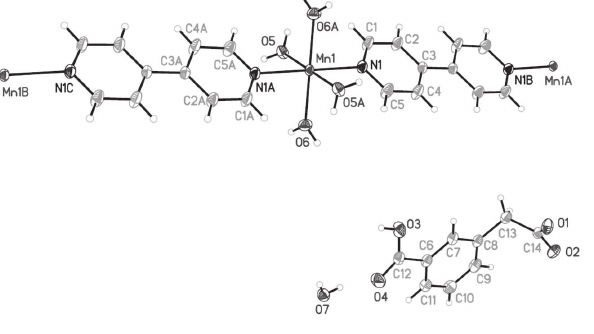
Table 1: Data collection and handling.